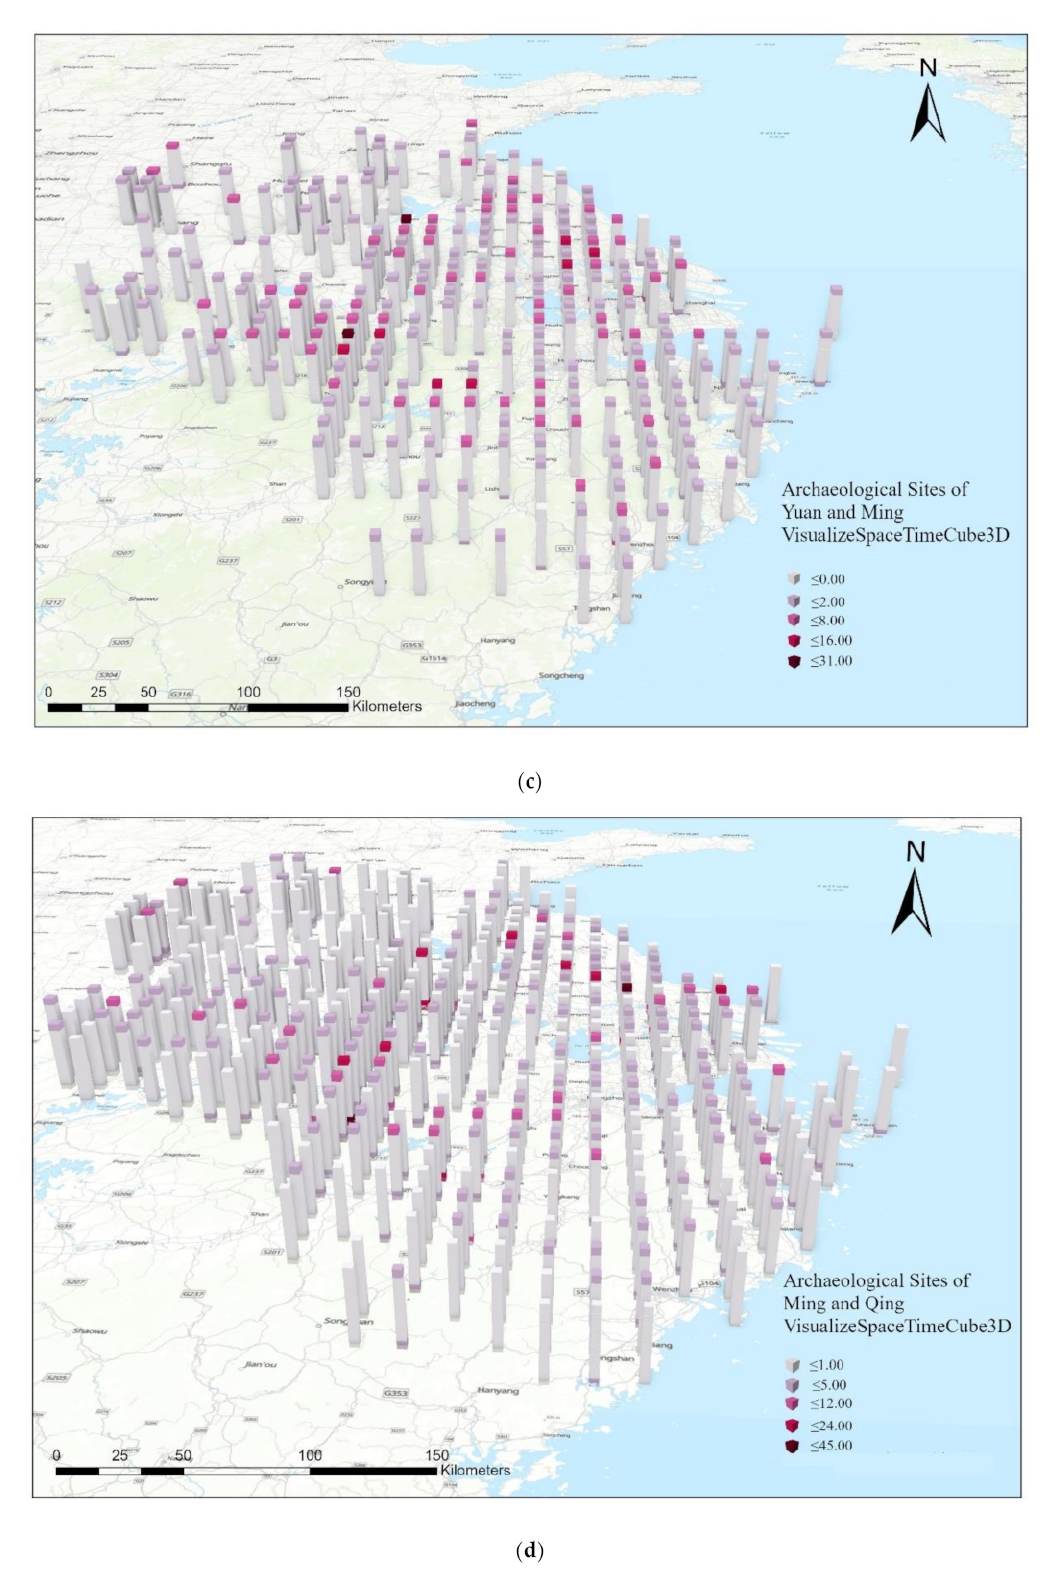
Figure 13. The space-time cube expression of Archaeological Sites. ( a ) The space-time cube expression Archaeological Sites of Tang and Song Dynasties, ( b ) the space-time cube expression Archaeological Sites of Song and Yuan Dynasties, ( c ) the space-time cube expression Archaeological Sites of Yuan and Ming Dynasties, ( d ) the space-time cube expression Archaeological Sites of Ming and Qing